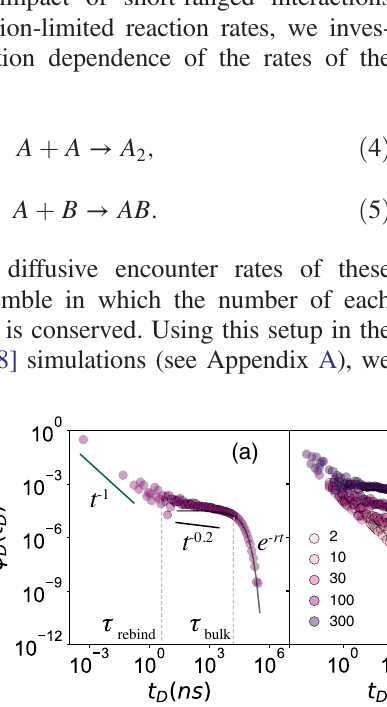
ð t Þ . There are three distinct regions separated by two timescales τ FIG. 2. (a) The dimerization time-interval distribution, ψ D D τ > τ . Reactions occurring at intervals t are described by a single rate, and their propensities can be computed by fitting the D bulk bulk < τ arises because the dimerization events are time correlated due to rebinding events. exponential tail. The t − 1 distribution for t D rebind ð t Þ for different monomer concentrations (shown in the legend with unit μ m − 2 ). The size of the region between (b) ψ D D τ < t < τ , i.e., the region with t − 0 . 2 scaling, decreases with decreasing monomer concentrations. In fact, at monomer D rebind bulk concentration of 10 μ m − 2 , this region is almost nonexistent, as illustrated by the exponential fit. The origin of the t − 0 . 2 scaling remains ð t Þ for different concentrations onto a single master unclear (see text). (c) Rescaling t by τ collapses ψ D D D bulk